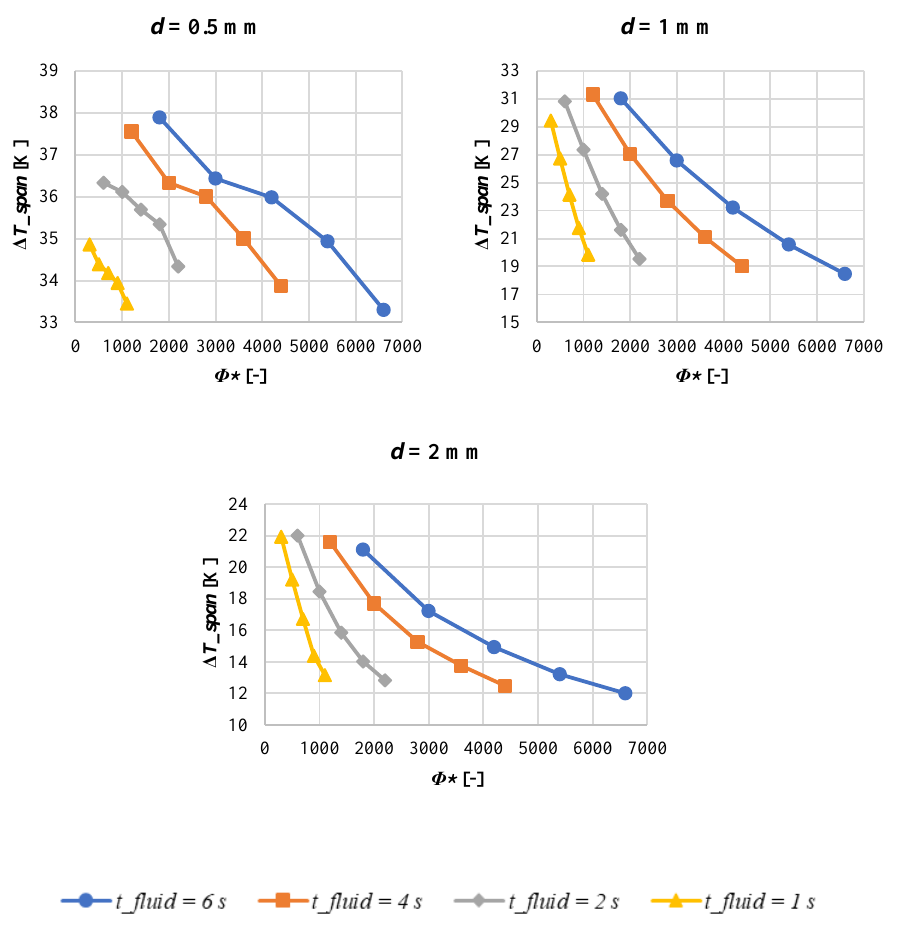
Figure 7. Temperature span as a function of the utilization factor, parametrized for the convective heat transfer time. Each subplot refers to a tested dataset of distance between two wires.